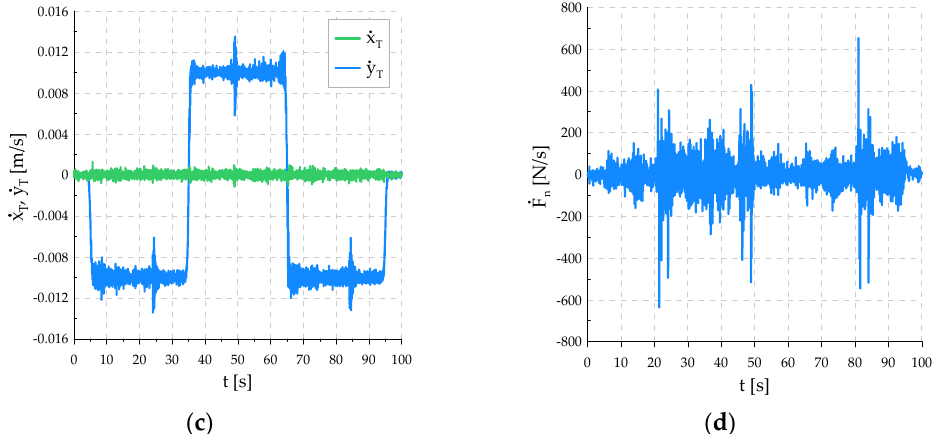
Figure 10. Realized trajectory of the system: ( a ) TCP coordinates on the directions tangent to the surface of the workpiece; ( b ) downforce; ( c ) TCP velocity in tangent directions; ( d ) derivative of downforce.